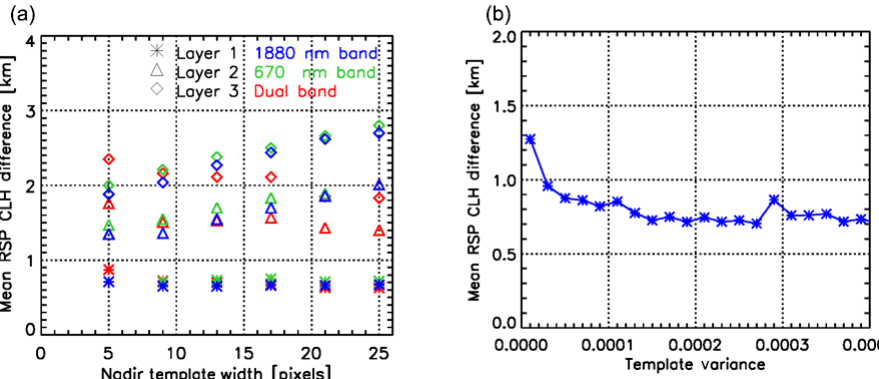
Figure 7. (a) RSP CTH error and nadir template width for the 1880nm band (blue), 670nm band (green) and the dual band (red). The first, second and third layers are shown as stars, triangles and diamonds, respectively. (b) Absolute CTH difference and template variance.